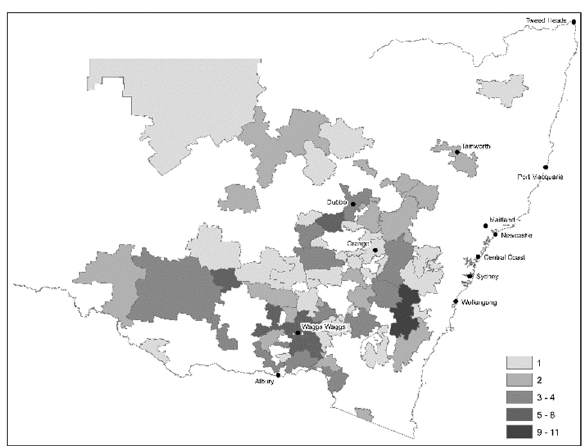
Figure 1. New South Wales map of distribution of the 2019 sheep survey participants (n = 145) by postcode. Average annual daily temperatures throughout New South Wales vary from minimum − 1.9 °C to maximum 36.3 °C.